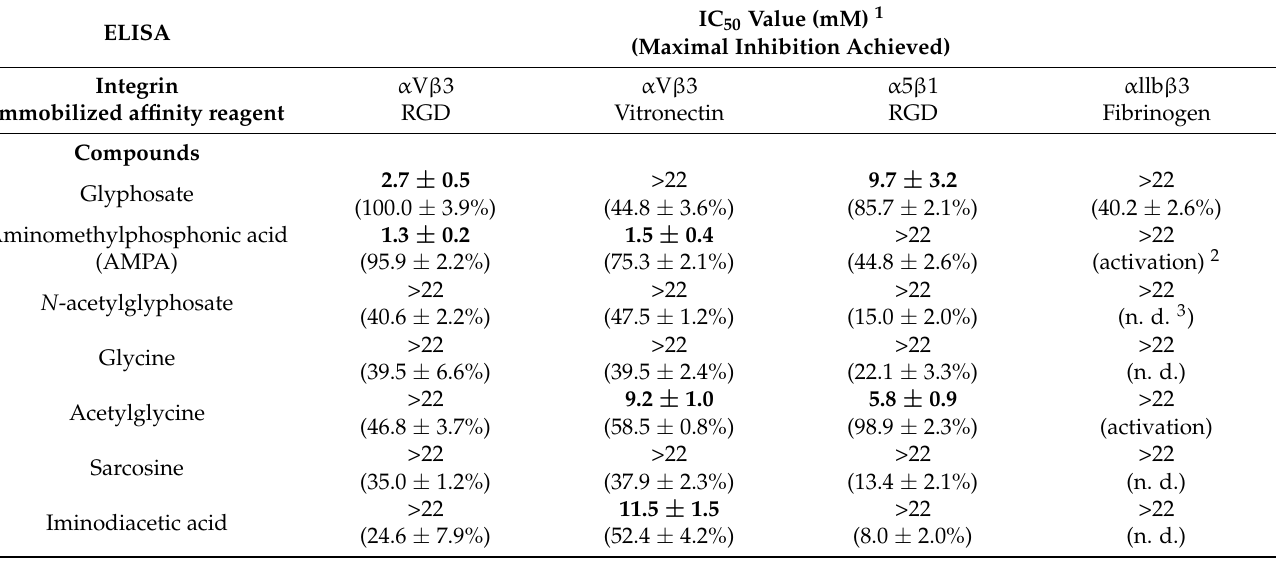
Table 2. IC 50 values and maximal inhibition (%) of the ligands (glyphosate and its structural analogs) investigated on